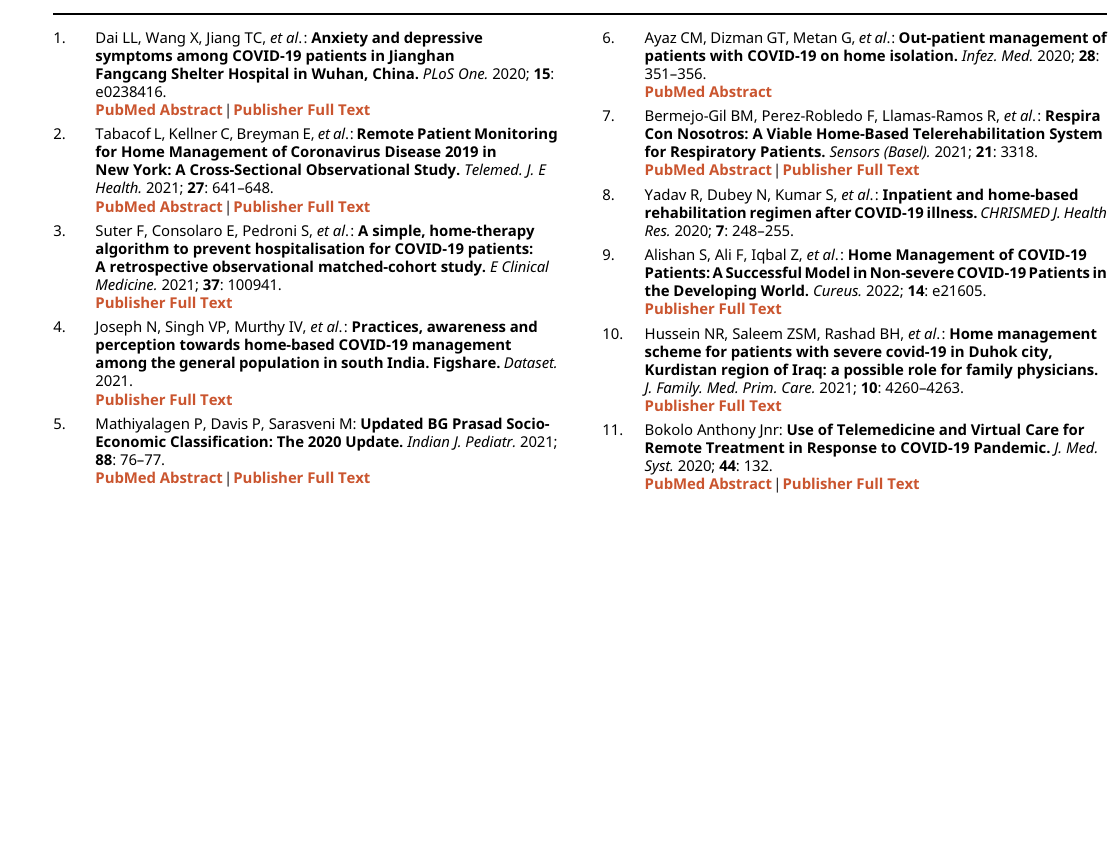
Figshare: ‘ Practices, awareness and perception towards home-based COVID-19 management among the general population in south India ’ . https://doi.org/10.6084/m9.figshare.17057183. 4 This project contains the following extended